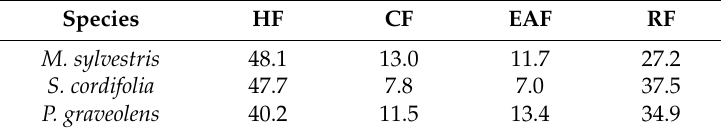
Table 1. Yields (% dry matter, w / w ) of fractions obtained from extracts of leaves. Species HF